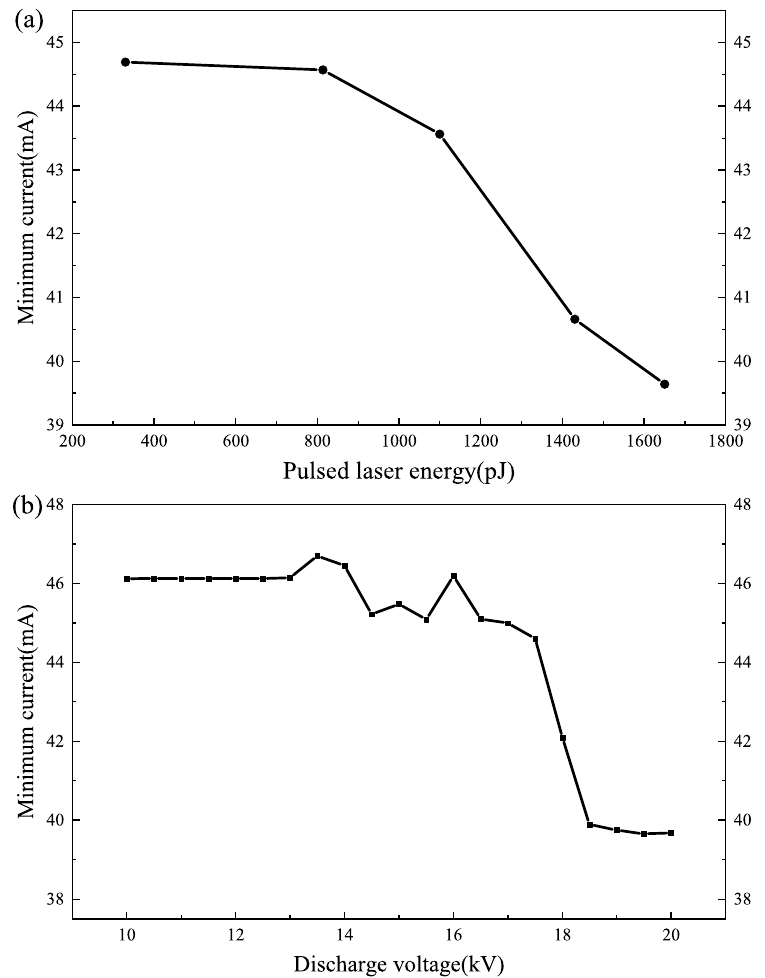
Figure 11. The curve of the lowest current value at Vcc port. ( a ) The curve of minimum current with the variation of pulsed laser energy. ( b ) The curve of minimum current with the variation of discharge